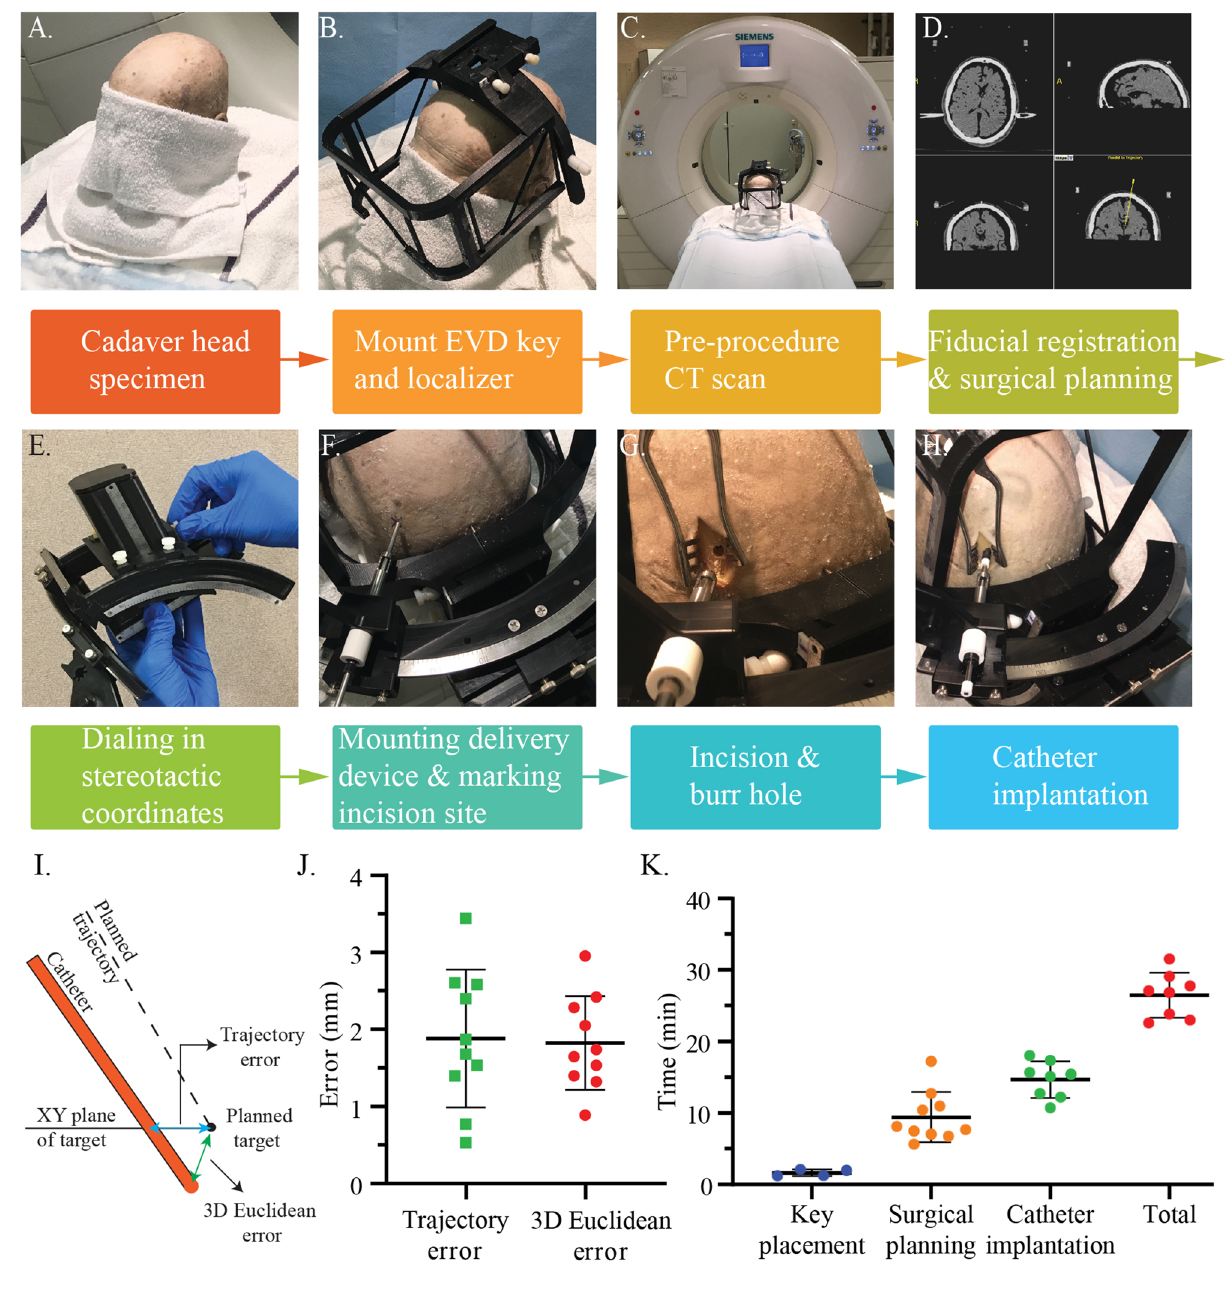
Figure 3. Surgical workflow ( A – H ) and results ( I – K ) from cadaveric pre-clinical study. ( A ) Specimen positioning for EVD catheter implantation. ( B ) The EVD key and localizer were mounted on the specimen and ( C ) a pre-procedure CT scan was obtained. ( D ) The CT data was transferred to surgical planning software and fiducial registration was performed. Stereotactic coordinates were obtained for a target close to the foramen of Monro and an appropriate trajectory (collar and arc angles) was chosen. ( E ) The stereotactic coordinates, and the arc and collar values obtained in the previous step were dialed into the stereotactic targeting device and the device was mounted on the EVD key. ( F ) A probe was used to mark the site of incision along the trajectory. ( G ) An incision was made at the marked site and a 5 mm burr hole was stereotactically drilled into the bone with the help of a drill guide and a standard #9 drill bit. ( H ) A metal catheter was then implanted into the brain and secured in place. A post-procedure CT scan and target verification was performed thereafter (not shown). ( I ) A schematic explaining the 3D Euclidean error and trajectory error. ( J ) The 3D Euclidean error and targeting error were found to be 1.8 ± 0.6 mm (n = 10) and 1.9 ± 0.8 mm (n = 10) ( K ) Stepwise and total procedure time: key placement (1.6 ± 0.4 min, n = 4), surgical planning (9.4 ± 3.5 min, n = 10), EVD catheter implantation (14.7 ± 2.6 min, n = 8) were completed in total 26.5 ± 3.1 min (n =